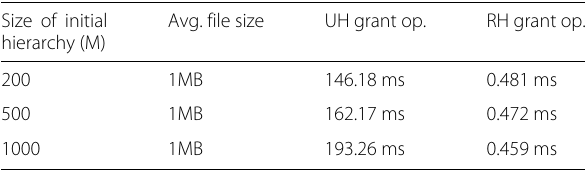
Table 7 Comparison of grant read operation cost Size of initial Avg. file size hierarchy (M)